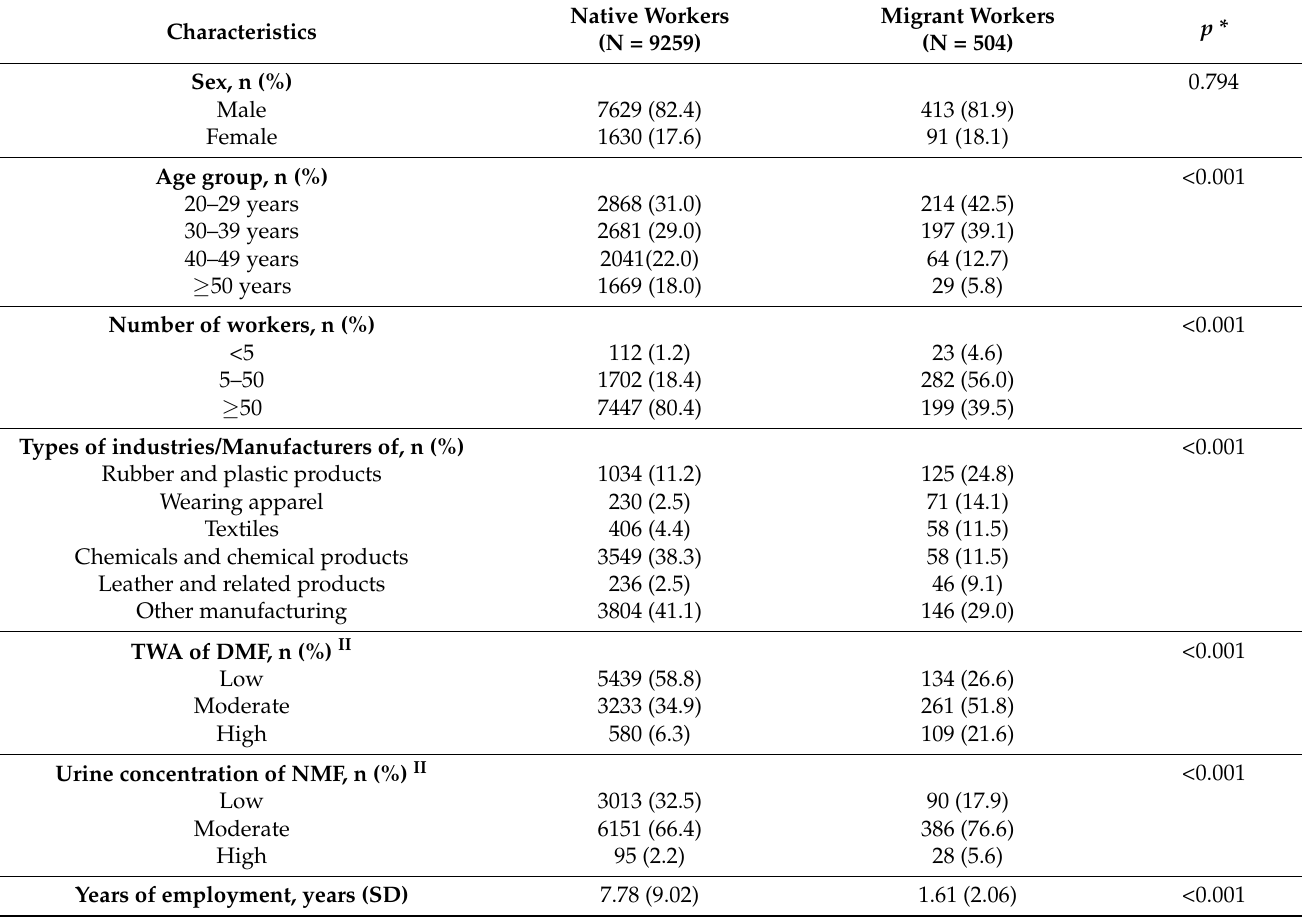
Table 1. Characteristics of native and migrant workers exposed to DMF in manufacturing industries